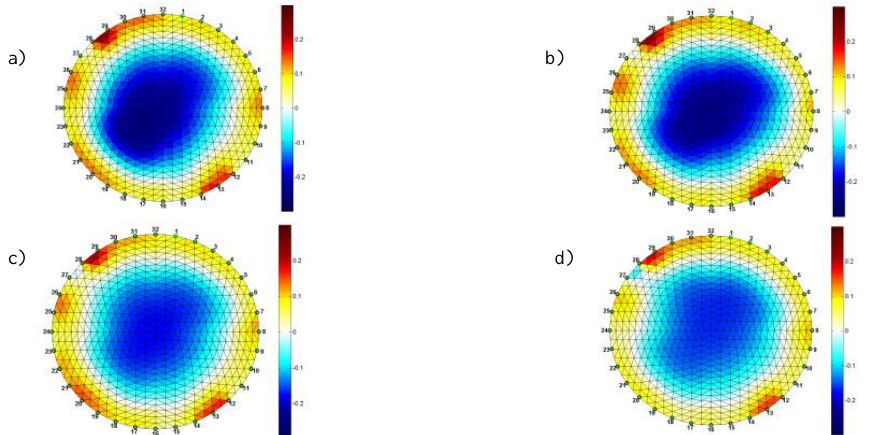
Figure 9. EIT images obtained with a concentration of ≅1% (w/w) of Pine fibres ( a – d ) for 0.5 m/s, 1 m/s, 1.5 m/s and 2.5 m/s, respectively.